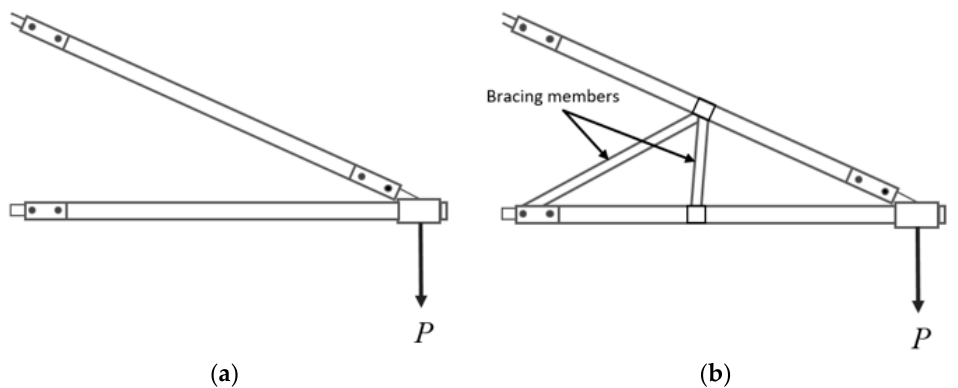
Figure 6. Cross-arm configurations: ( a ) current design configuration; and ( b ) braced design config- uration.